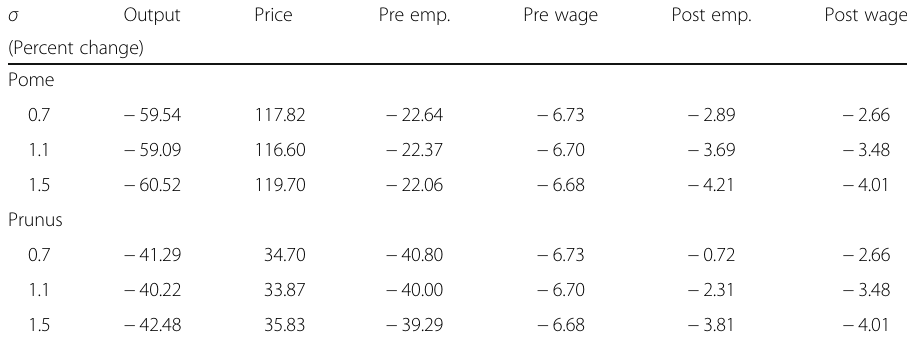
Table 5 Post-shock and fixed wage and transportation effect percent